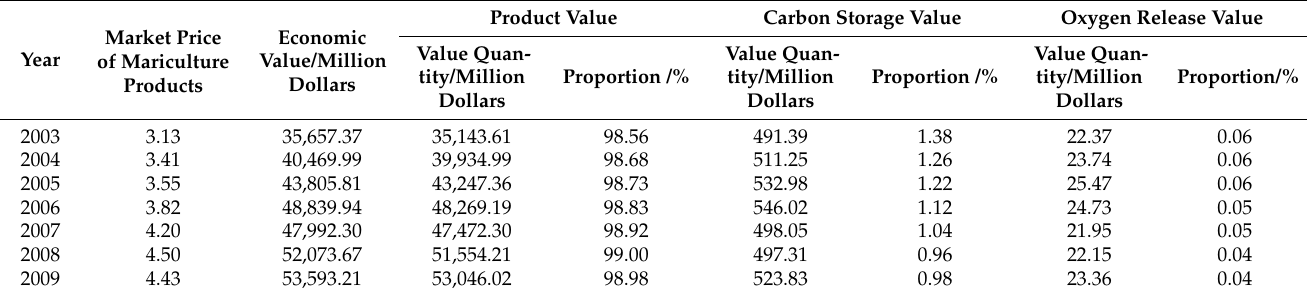
Table 3. Economic value of the shellfish and algae carbon sink from 2003 to